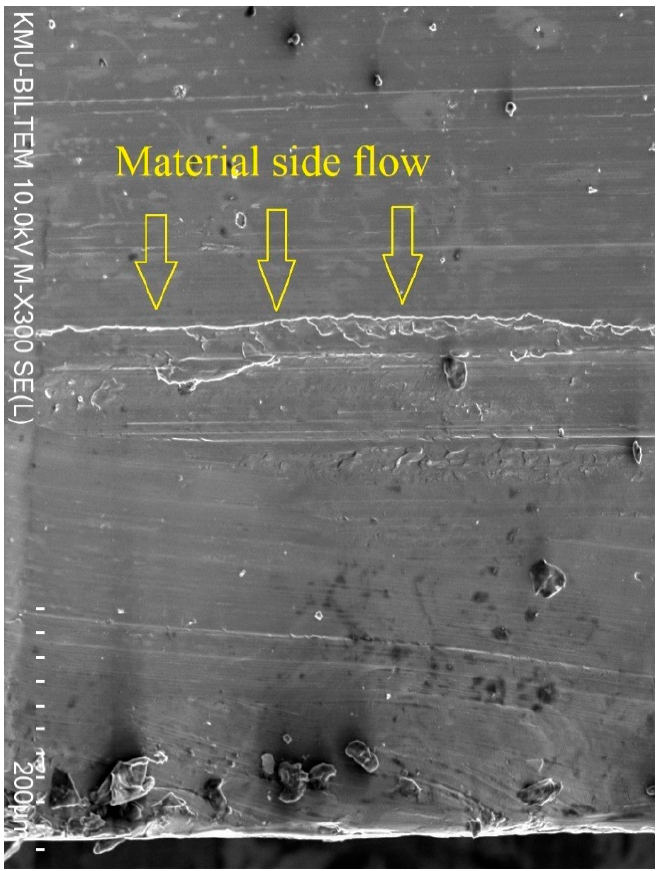
Figure 6. SEM image of hole at exit side drilled using TiN-coated tools, showing the material side flow phenomena.